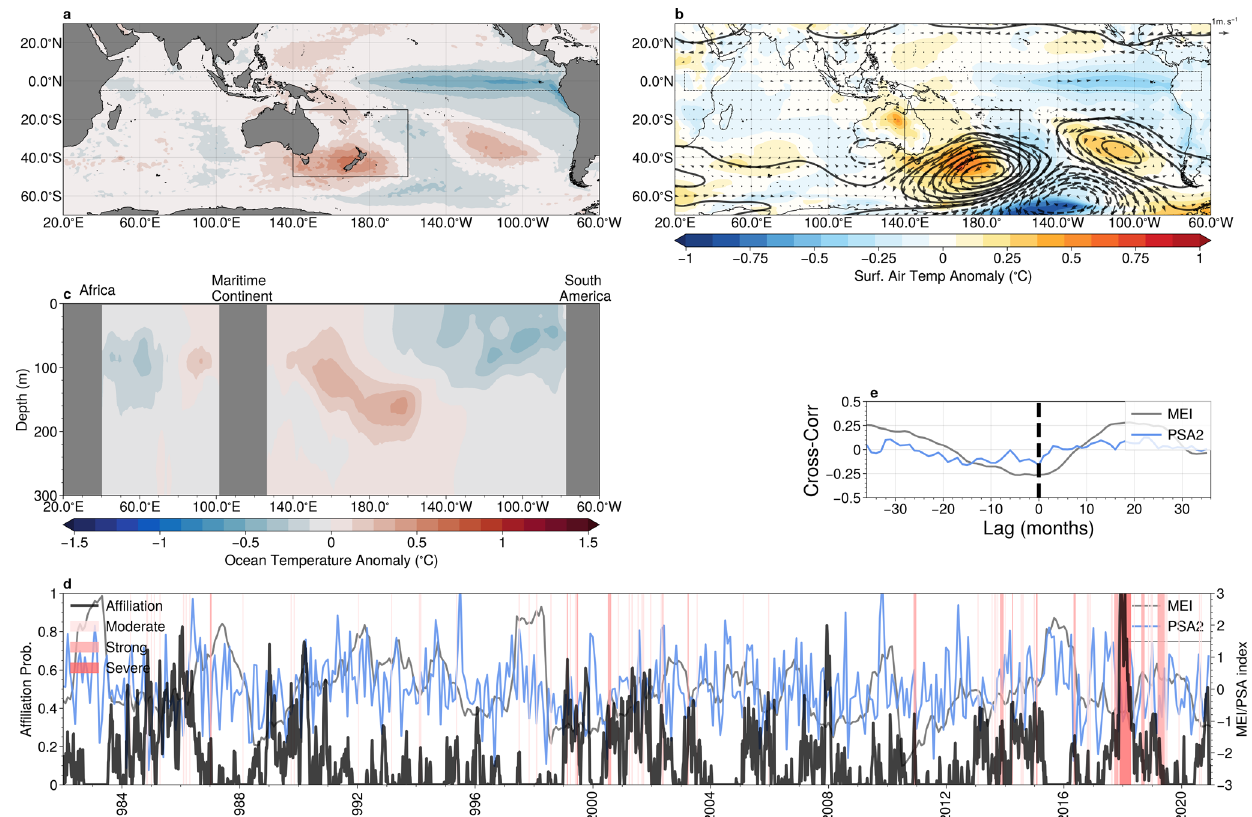
Fig. 6 | Teleconnections associatedwithmarine heatwavesin the TasmanSea. a Sea-surface temperature anomaly; b surface air temperature (colours) with anomalous mid-tropospheric (500hPa) geopotential height (contour lines, con- tour interval 5m) and winds (vectors); and c subsurface ocean temperatures (averaged latitudinaly between 5°S and 5°N within the region indicated by dashed lines in panels a and b ), associated with archetype #2; d The af fi liation time-series